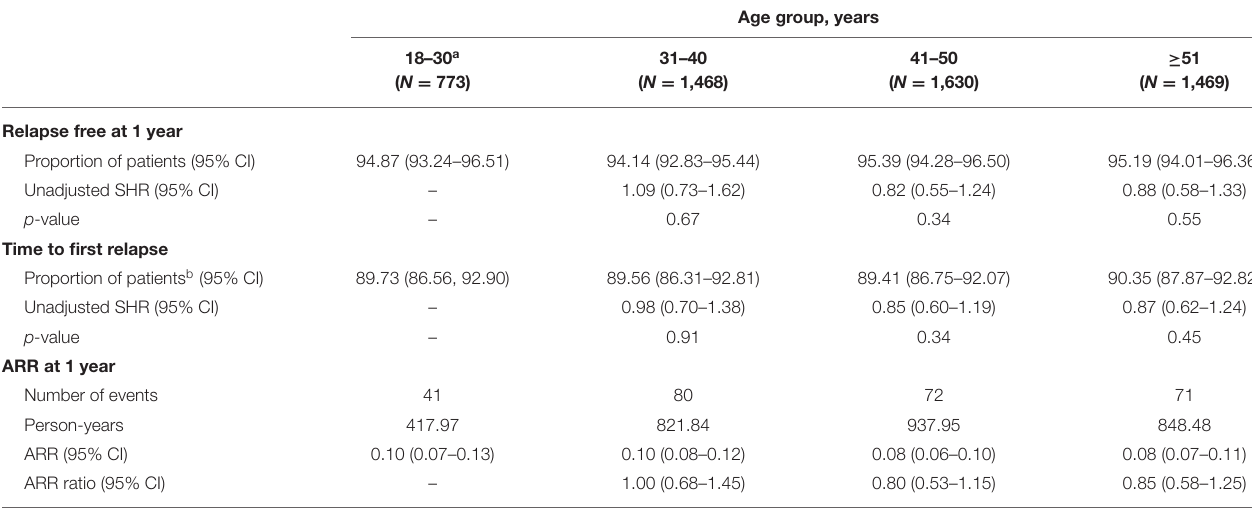
TABLE 2 | Proportion of patients relapse free and annualized relapse rate at 1 year, and time to first relapse after initiation of sc IFN β -1a